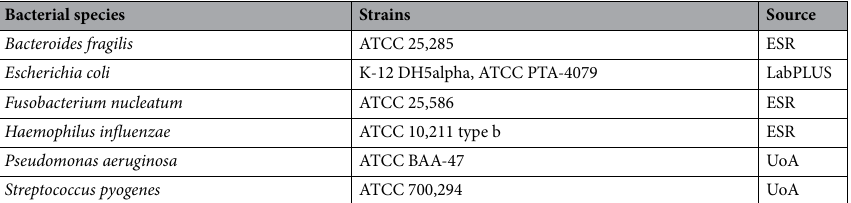
Table 2. Bacterial cell cultures used in this study to test and optimise FISH probes. ATCC American Type Culture Collection, ESR Institute of Environmental Science and Research Limited, UoA University of